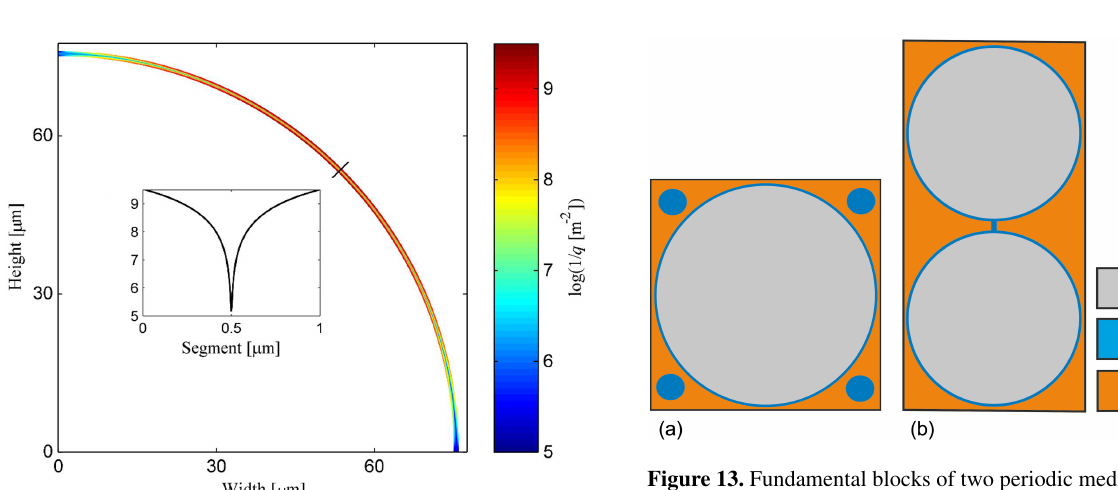
Figure 11. Zoom-in of the top right quadrant of the model shown in Fig. 9 displaying the fluid velocity components ( V x and V z ) for a grain diameter d = 150µm and a thickness of the interfacial water film a = 1µm, at the characteristic frequency. These fields correspond to the fluid pressure field shown in Fig. 10. The insets illustrate the profiles across the interfacial film where it is crossed by a black line.